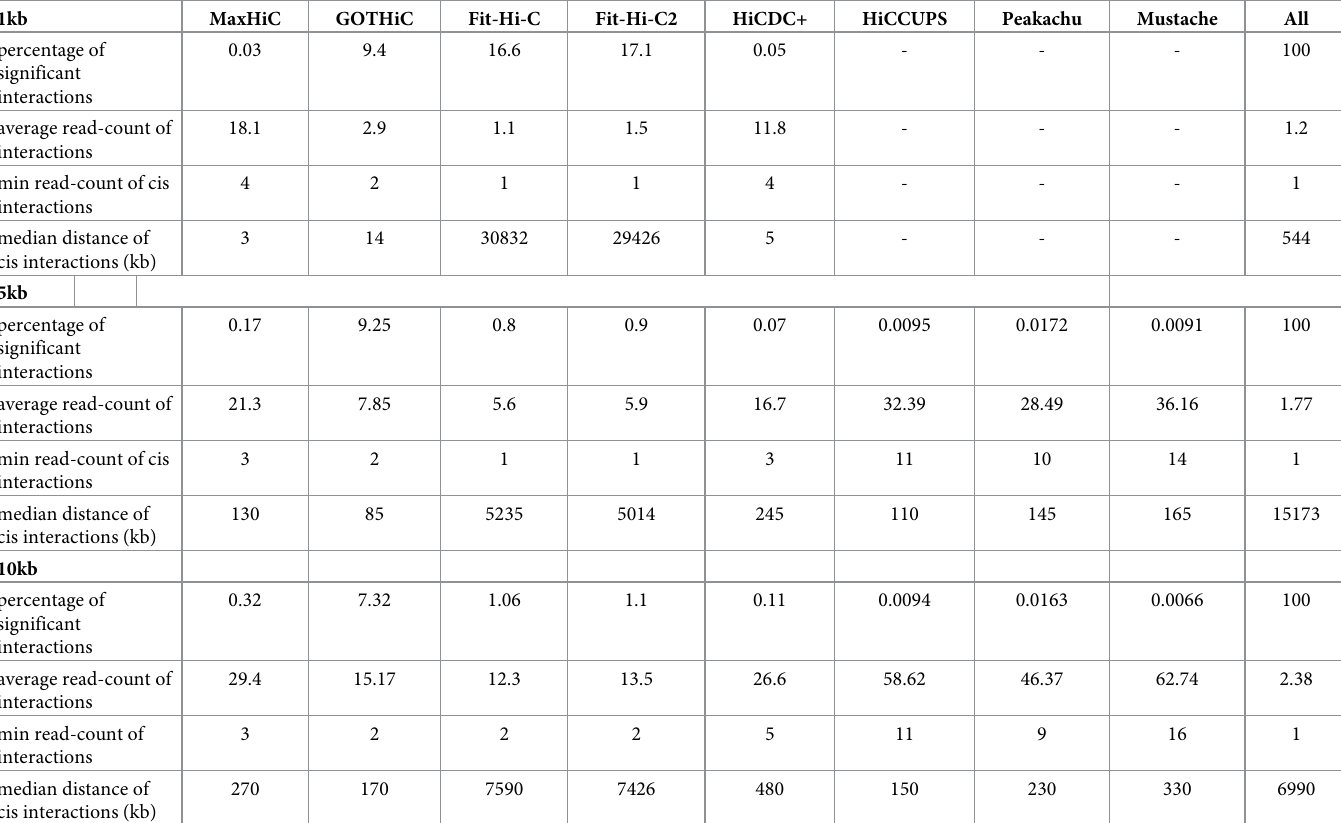
Table 1. Statistical summary of significant interactions identified by MaxHiC, GOTHiC, Fit-Hi-C, Fit-HiC2, HiCDC+, HiCCUPS, Peakachu, and Mustache in the GM12878 Hi-C library from Rao et al . [5]. at bin-sizes 5kb and 10kb. Statistical summaries for HMEC library are provided in S2 Table , respectively.